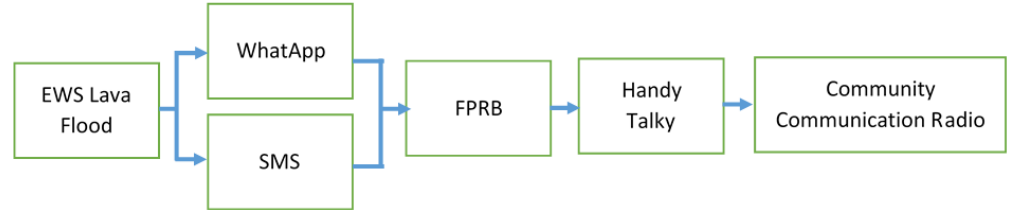
Figure 3. Block diagram of radio communication methods.